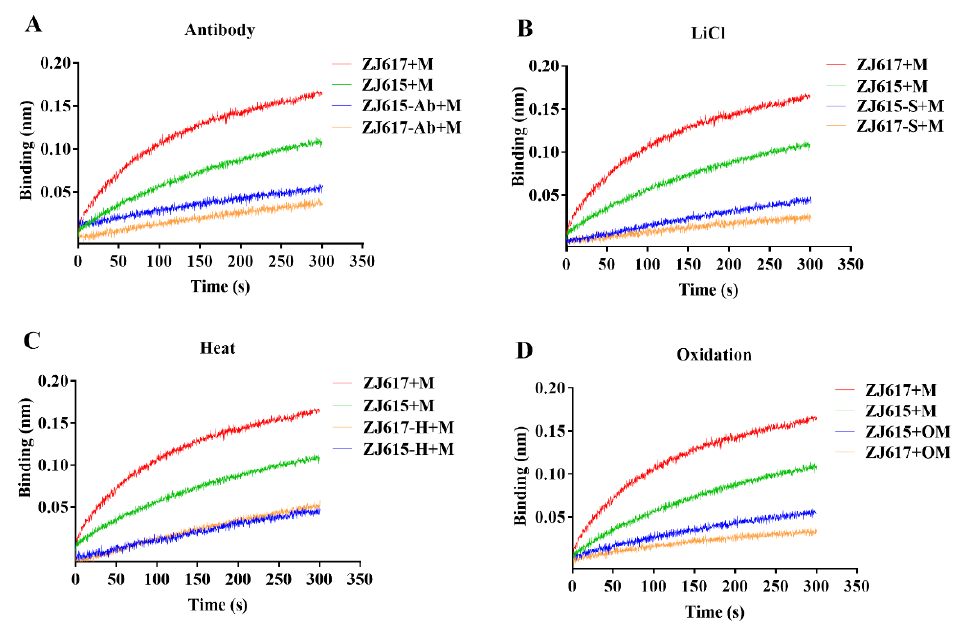
Figure 5. Interaction kinetics between L. reuteri ZJ617 and ZJ615 and porcine intestinal mucin determined using Octet apparatus. Bacteria were complexed on a chip, and mucin (M) was used as the mobile phase. ( A ) Kinetics when L. reuteri strains were blocked with an anti-GAPDH antibody (labeled “Ab”). ( B ) Kinetics when L. reuteri strains were treated with LiCl to remove surface proteins (labeled “S”). ( C ) Kinetics when L. reuteri strains were heat-inactivated at 80 °C for 30 min (labeled “H”). ( D ) Kinetics when mucin was oxidized with periodate (labeled “O”).